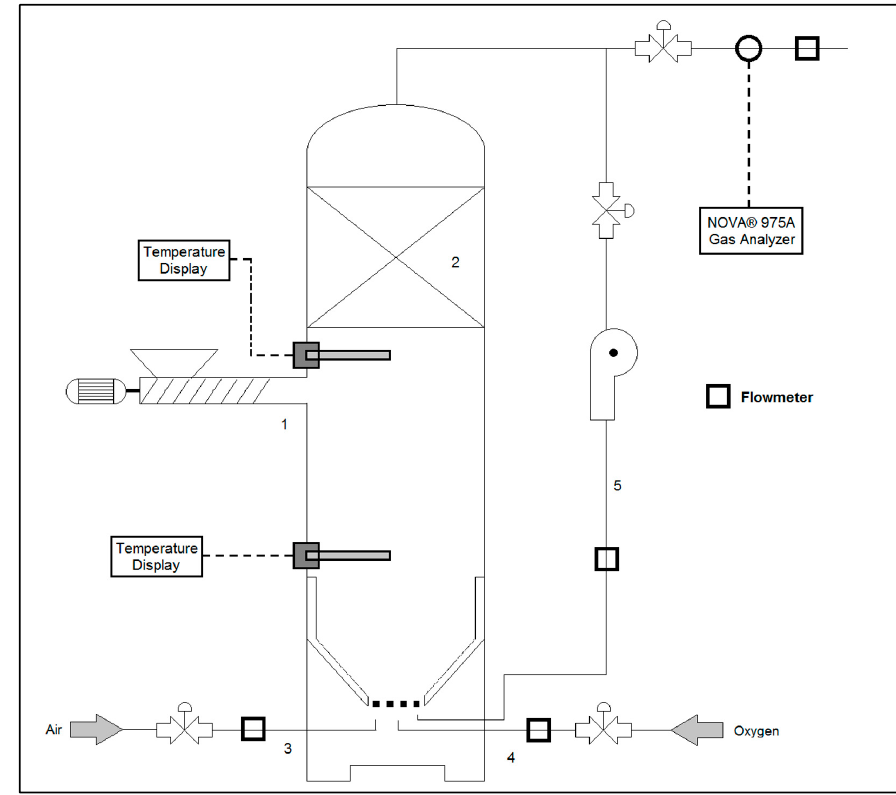
Figure 1. Gasification facility scheme. Table 1. Characteristics of the gasification facilities.